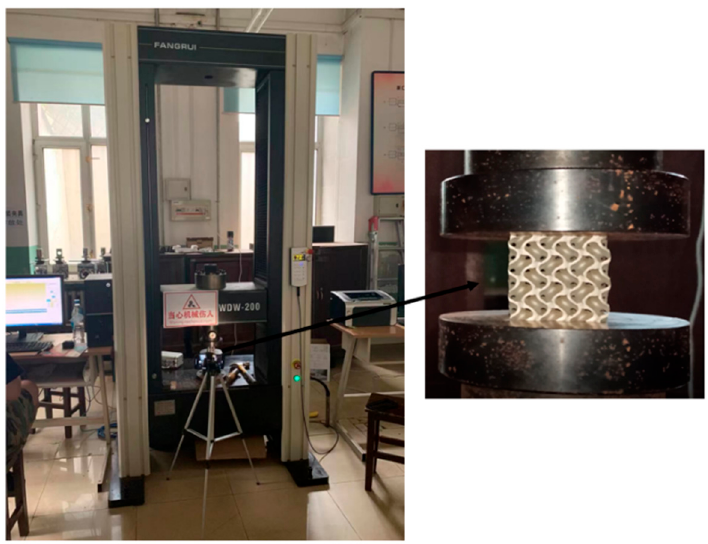
Figure 4. Universal mechanical testing machine and test process.